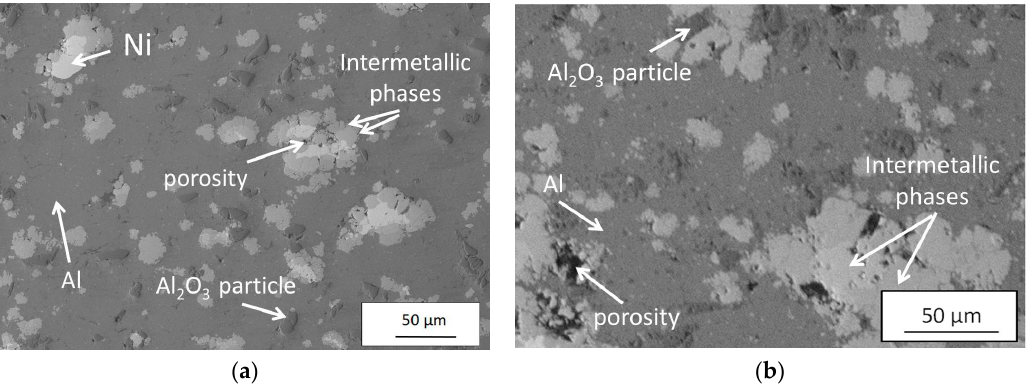
Figure 6. Micrographs (SEM, BSE) of 49% Al coating heated in furnace at 560 °C ( a ) and 620 °C ( b ).